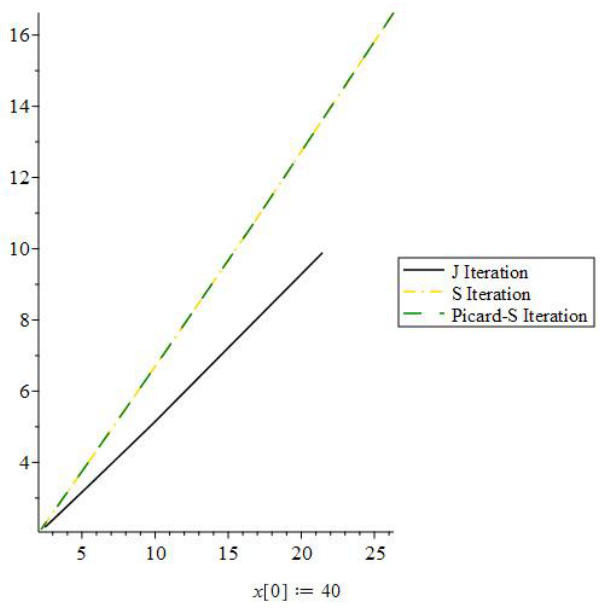
Figure 2. J iteration process convergence when the initial value is